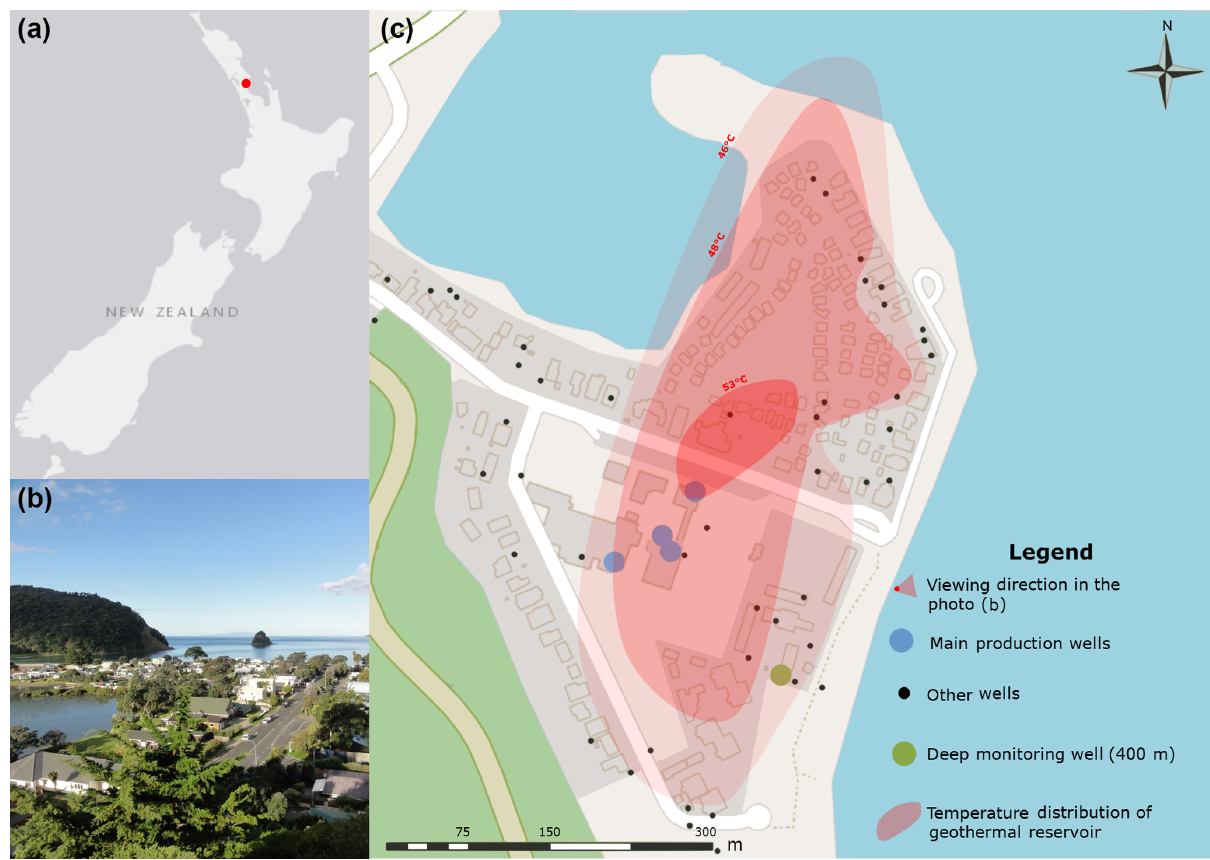
Figure 1. Location of Waiwera on the Northern Island of New Zealand (a) . Photograph of the village (b) . Map of Waiwera (c) showing locations of the main production wells (blue dots), smaller wells of mainly private users (black dots), the monitoring well (green dot) and the approximate temperature distribution of the geothermal